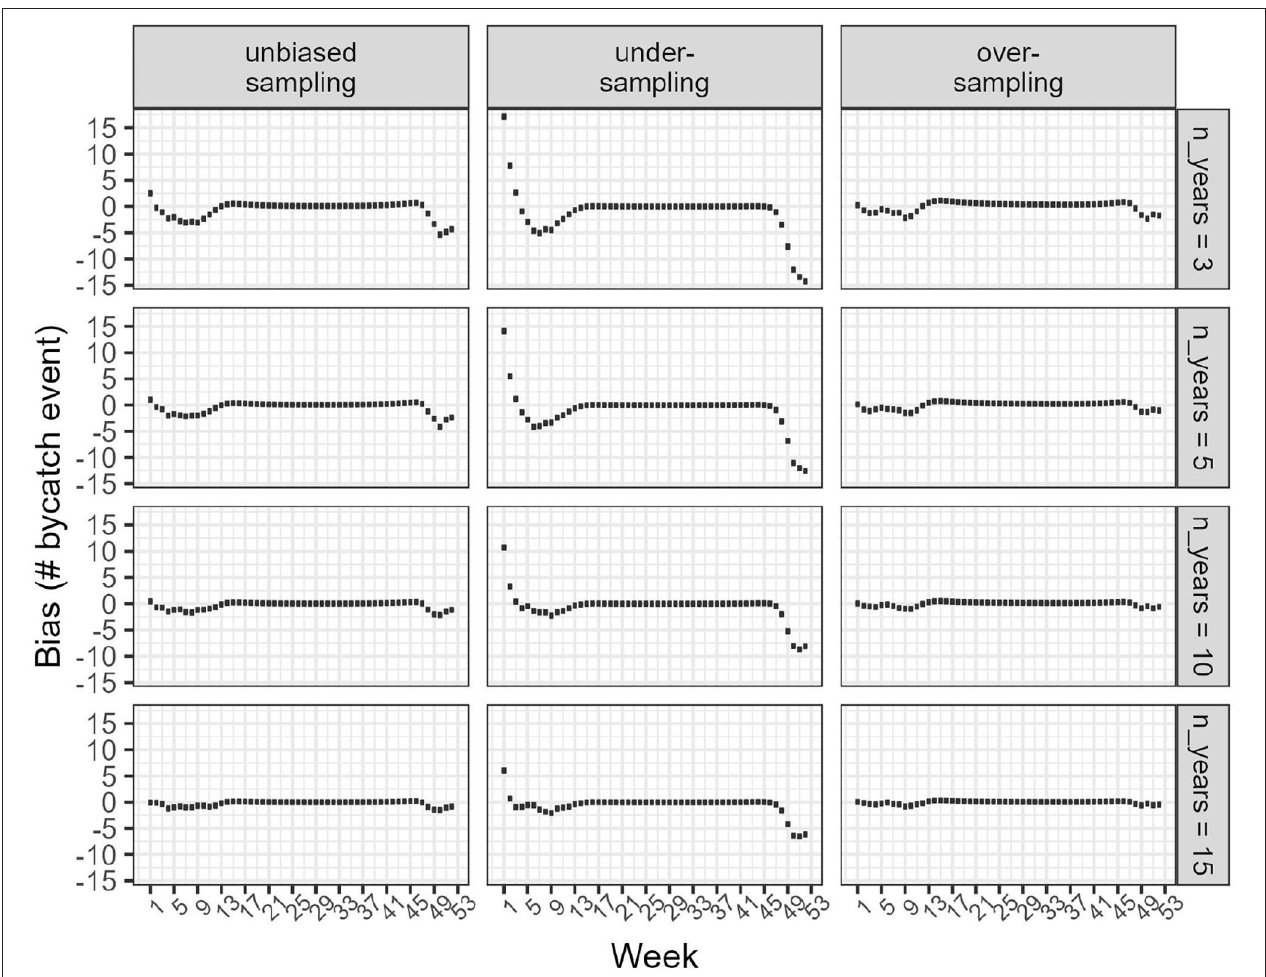
FIGURE 6 | Box plots of bias (in number of estimated bycatch events compared to the truth) in the weekly model-based estimates of bycatch events. Left: data sampling was unbiased. Middle: Under-sampling. Right: Over-sampling. Each row corresponds to data simulated for a different number of